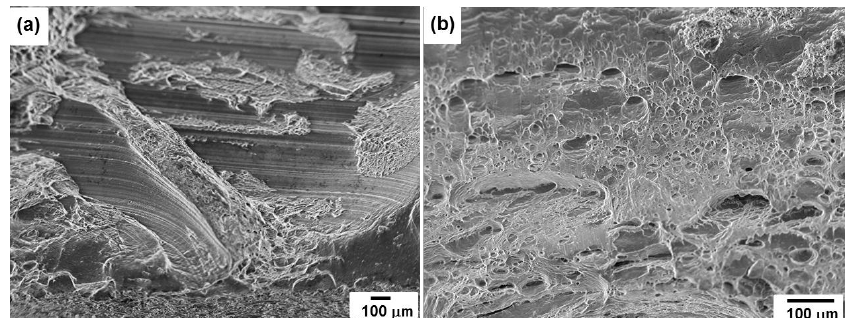
Figure 11. SEM images showing the morphologies of the fractured surfaces of the joints produced at a revolutionary pitch of ( a ) 1; and ( b ) 0.5 mm/rev.